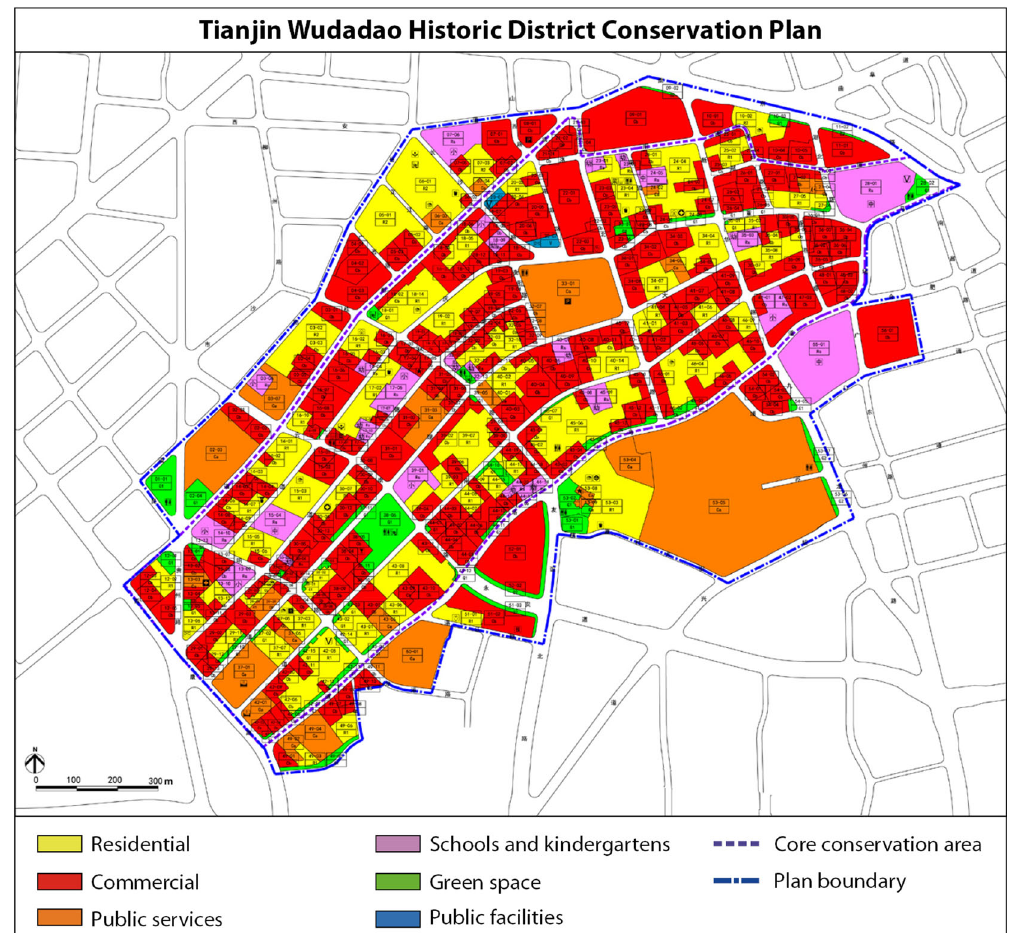
Fig. 8 Conservation plan of Wudadao historic and cultural district (Source: Tianjin municipality,